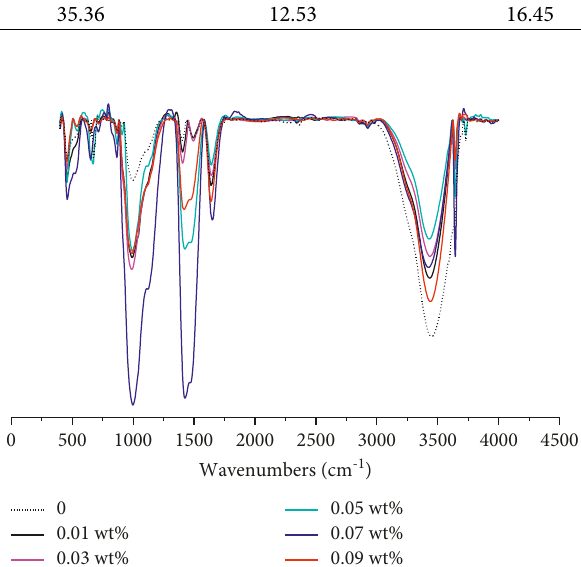
Figure 10: FTIR analysis of ZRJ-S1 reinforced cement-based